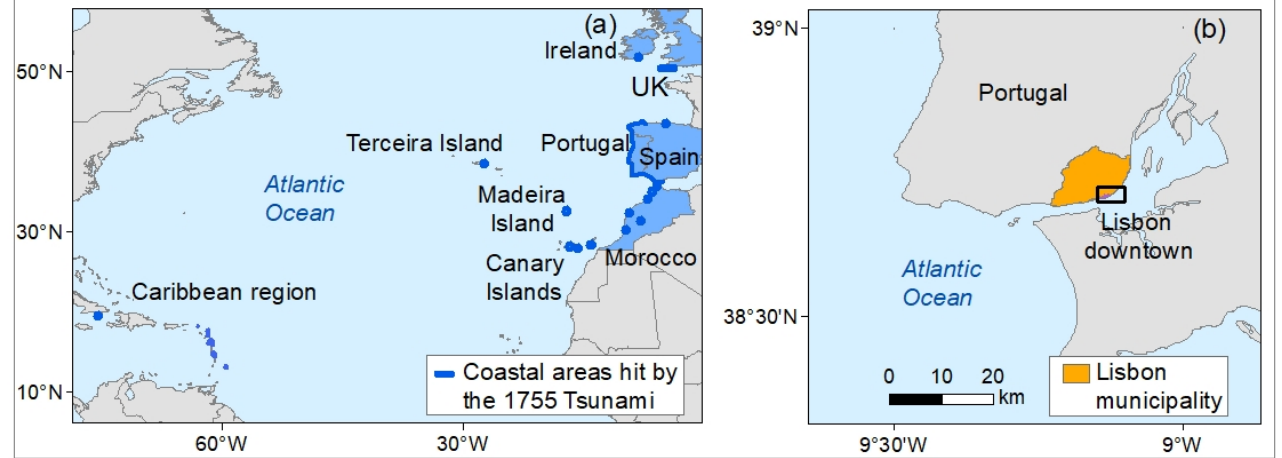
Figure 1. Geographical framework of the study area: ( a ) countries and regions hit by the 1755 tsunami; ( b ) Location of Portugal, the Lisbon municipality and Lisbon downtown.